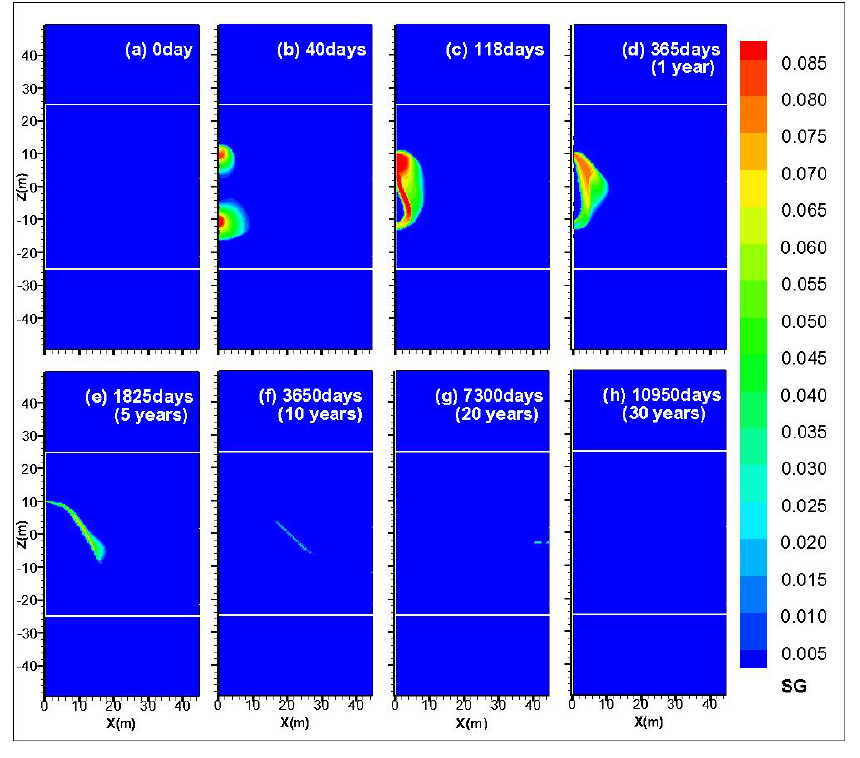
during hydrate dissociation (the G